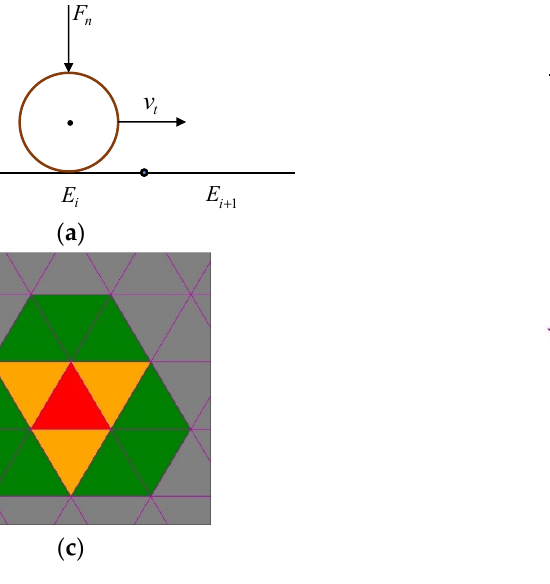
Figure 2. Mesh deformation procedure [25]. ( a ) Particle in contact with the surface Ai of the mesh element; ( b ) displacement of the mesh element; ( c ) side view of the interconnection between nodes and ( d ) top view of the wear representation. ∆ t The wear depth d t + and the new position of nodes of the mesh element p t + i